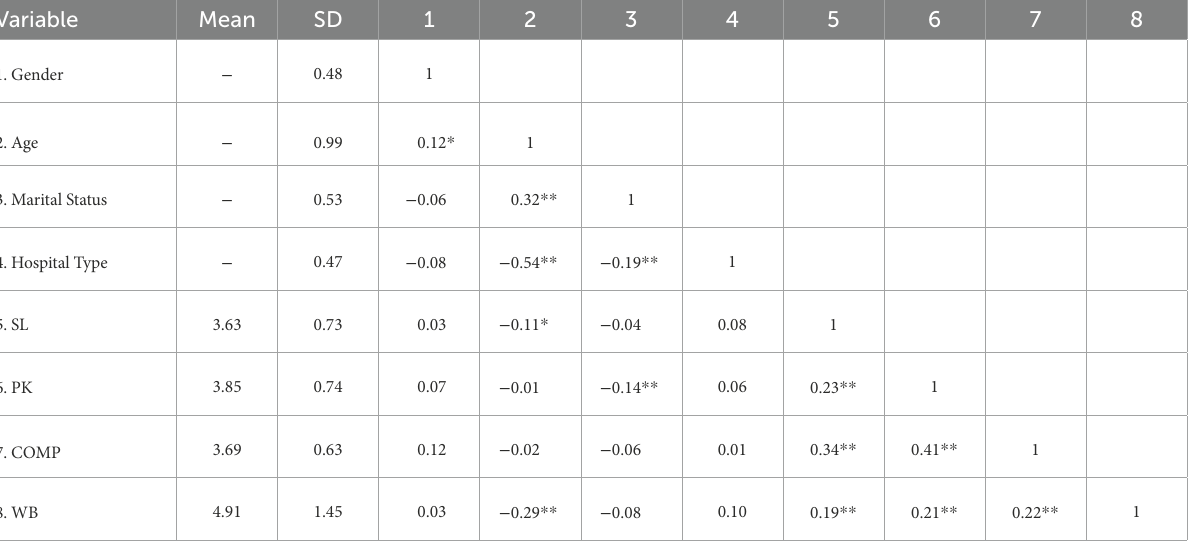
TABLE 3 Mean, standard deviation, and correlations. Variable